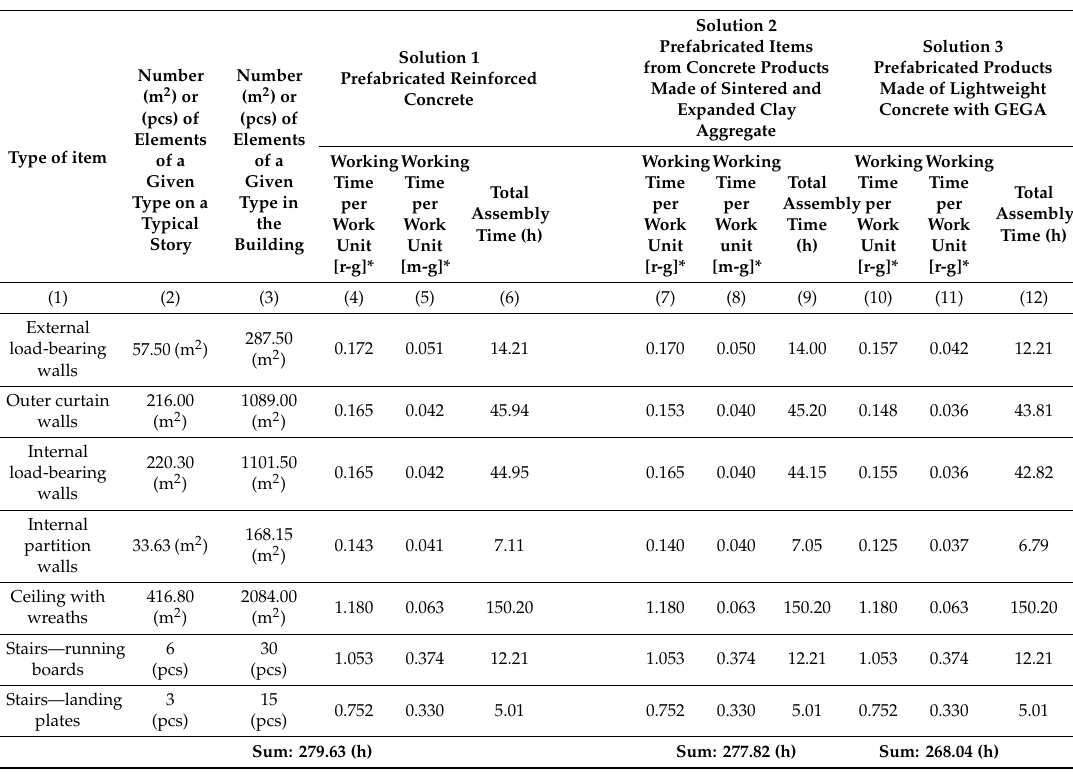
Table 7. Time analysis—assembly of prefabricated elements according to three solutions.